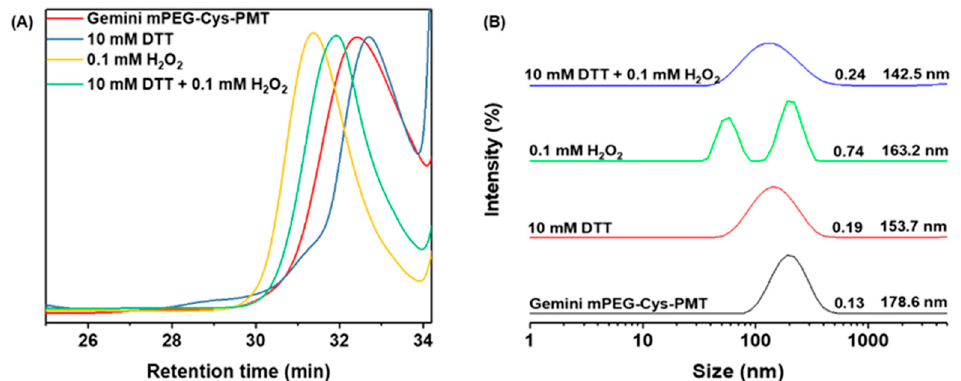
Figure 3. Gel permeation chromatography (GPC) traces of gemini mPEG-Cys-PMT, gemini mPEG-Cys-PMT treated with 10 mM DTT, gemini mPEG-Cys-PMT oxidized by treatment with 0.1 mM H 2 O 2 , and gemini mPEG-Cys-PMT treated with 10 mM DTT and 0.1 mM H 2 O 2 measured using distilled water containing 0.05 M NaNO 3 as mobile phase ( A ) and dynamic light scattering (DLS) diagrams by intensity of gemini mPEG-Cys-PMT micelles, micelles treated with 10 mM DTT, micelles treated with 0.1 mM H 2 O 2 , and micelles treated with 10 mM DTT and 0.1 mM H 2 O 2 for 12 h in distilled water ( B ).